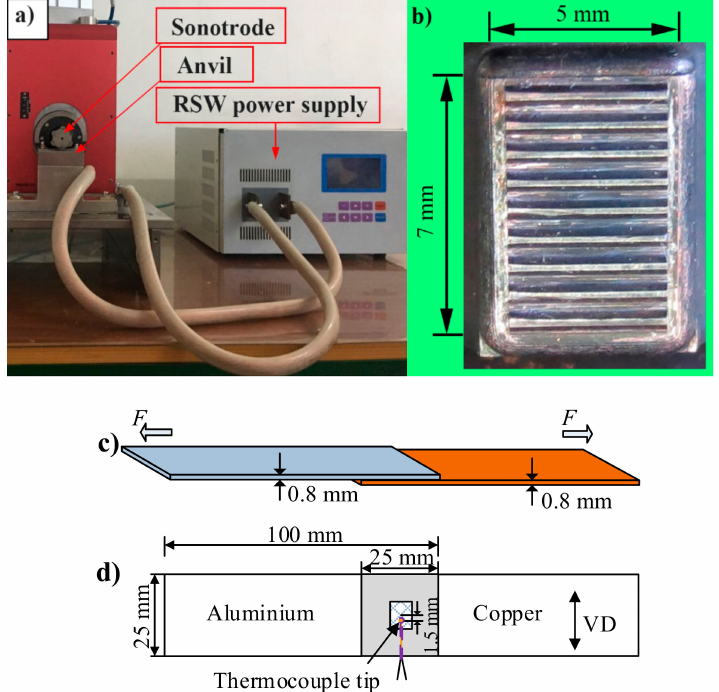
Figure 3. ( a , b ) The RUSW machine setup; ( c ) configuration of the tensile-shear, and ( d ) temperature measurement tests